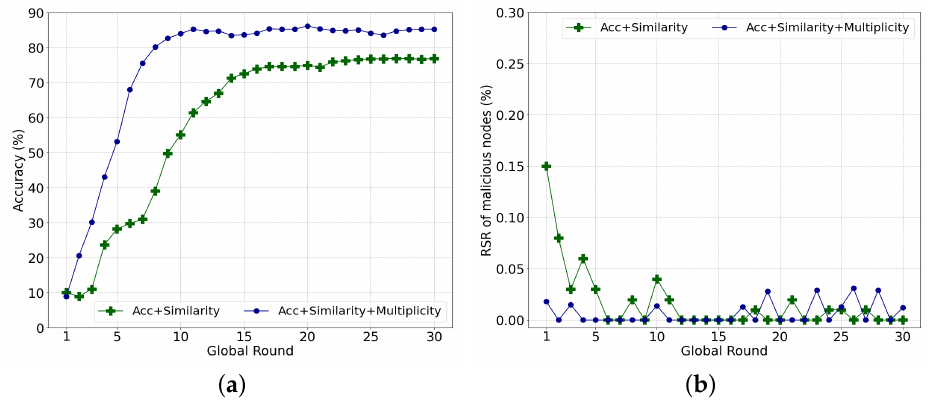
Figure 5. Effect of multiplicity on performance. ( a ) Global model accuracy; ( b ) Ratio of reference score of malicious nodes to total reference score per